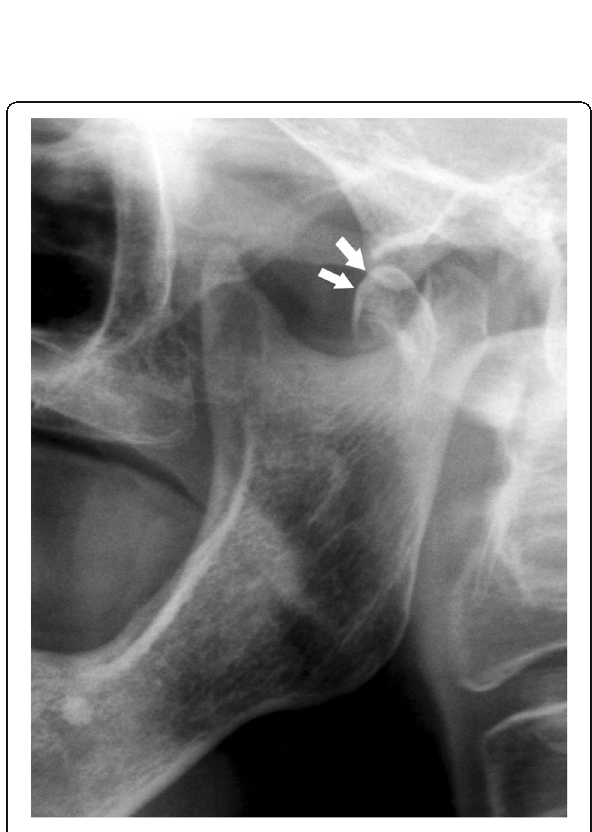
Fig. 17 Condylar process fracture. Dislocation. Cropped panoramic radiograph. The bone fragments are not in line and the condylar head moves out from the glenoid fossa